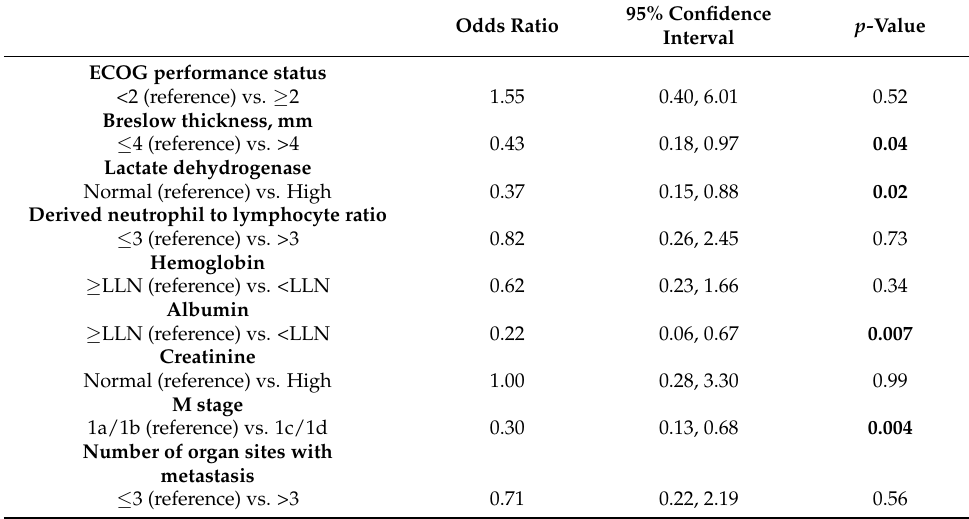
Table 4. Multivariable analysis of patient factors associated with survival >3